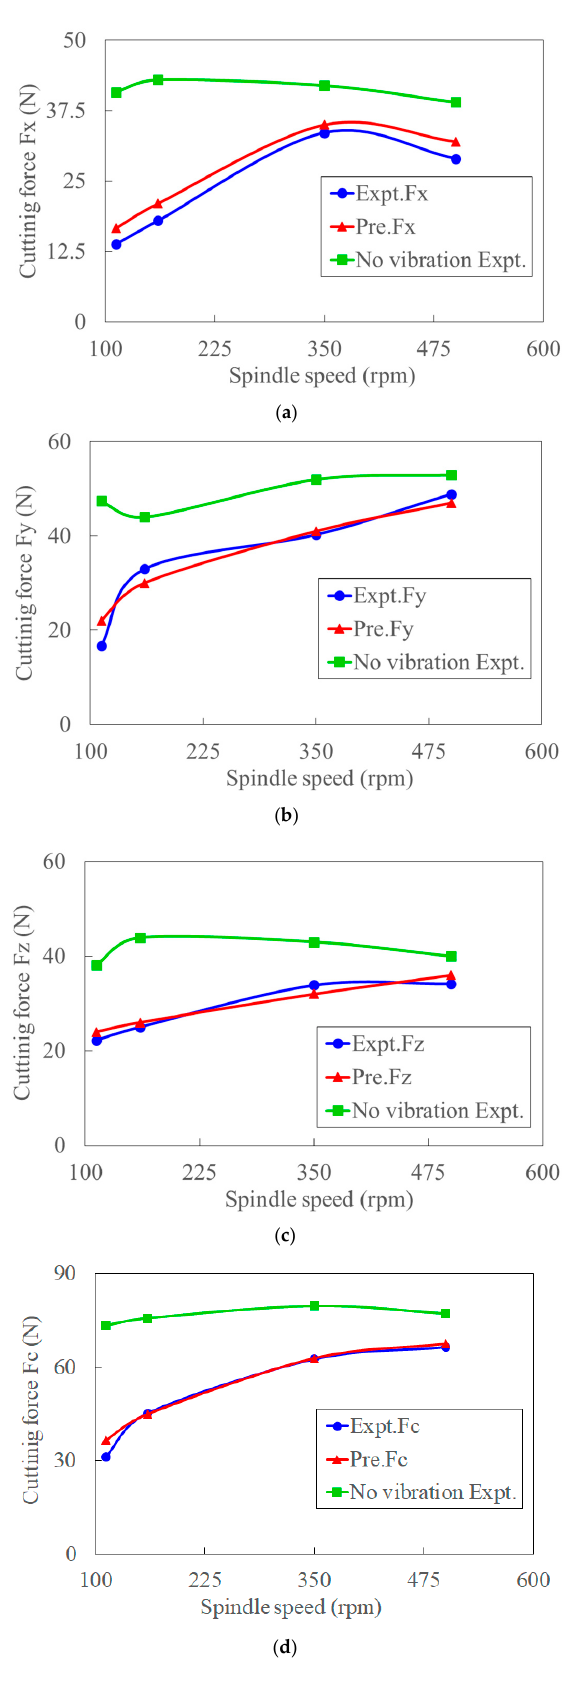
Figure 11. The typical work-piece ( a ) and cutting forces ( b ) in cutting with and without ultrasonic vibration.